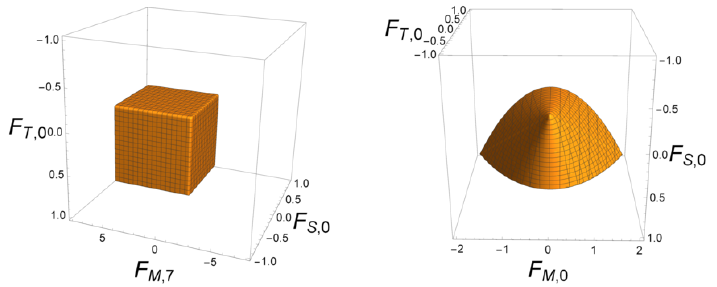
Figure 26 . Representative cases for operators from three di(cid:11)erent categories. Allowed parameter spaces are described by a pyramid or a